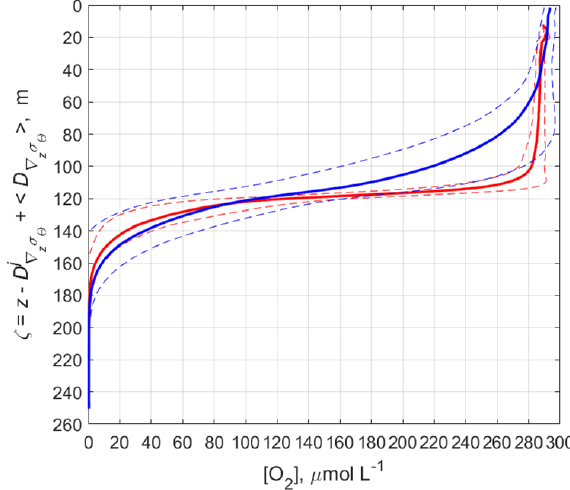
Figure 7. Mean vertical profiles of potential density versus distance Figure 8. Mean profiles of dissolved oxygen content for I σ 14 < from the depth of the maximum density gradient in the pycnocline. 3 . 5molm − 2 (red curve) and I σ 14 ≥ 3 . 5molm − 2 (blue The mean values were calculated for an ensemble that consists of M individual profiles σ j ( z ), where z is the depth and j = 1, ..., M ; (cid:50) each are vertically displaced from the depth of the maximum den- (cid:105) , +(cid:104) D ∇ sity gradient in the pycnocline D j ∇ : ζ = z − D j ∇ z σ θ z σ θ z σ θ where ∇ z σ θ = (cid:49)σ θ /(cid:49)z and the angle brackets denote the time av- erage. The red curve represents the mean profile for the cases where I σ 14 < 3 . 5molm − 2 . The blue curve is the mean profile for the cases where I σ 14 ≥ 3 . 5molm − 2 .